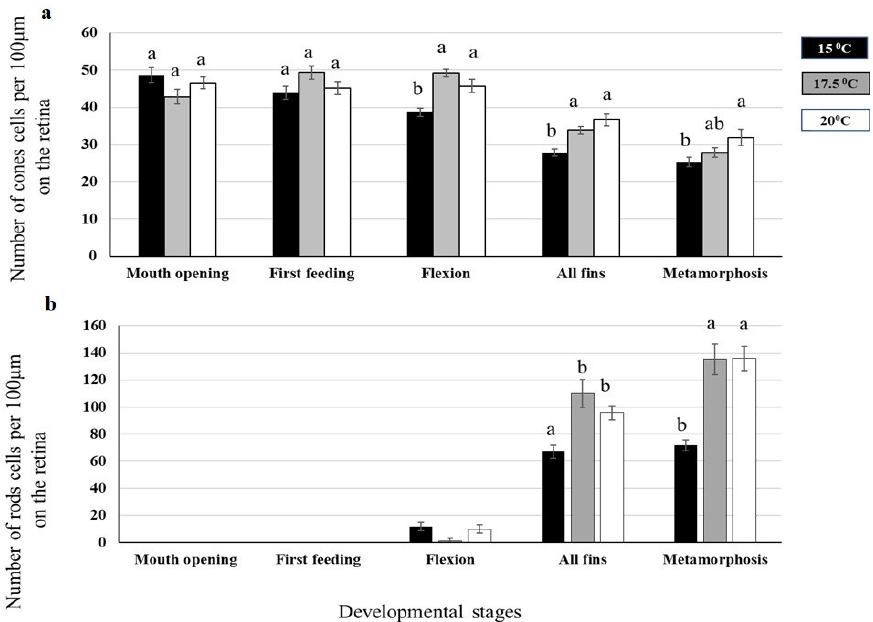
Figure 1. ( a ) Number of cone and ( b ) rod cells at five different developmental stages of European sea bass reared at three different temperatures (15 °C, 17.5 °C, and 20 °C) from the egg until the metamorphosis stage (n = 3). Different letters denote significant differences between experimental groups.